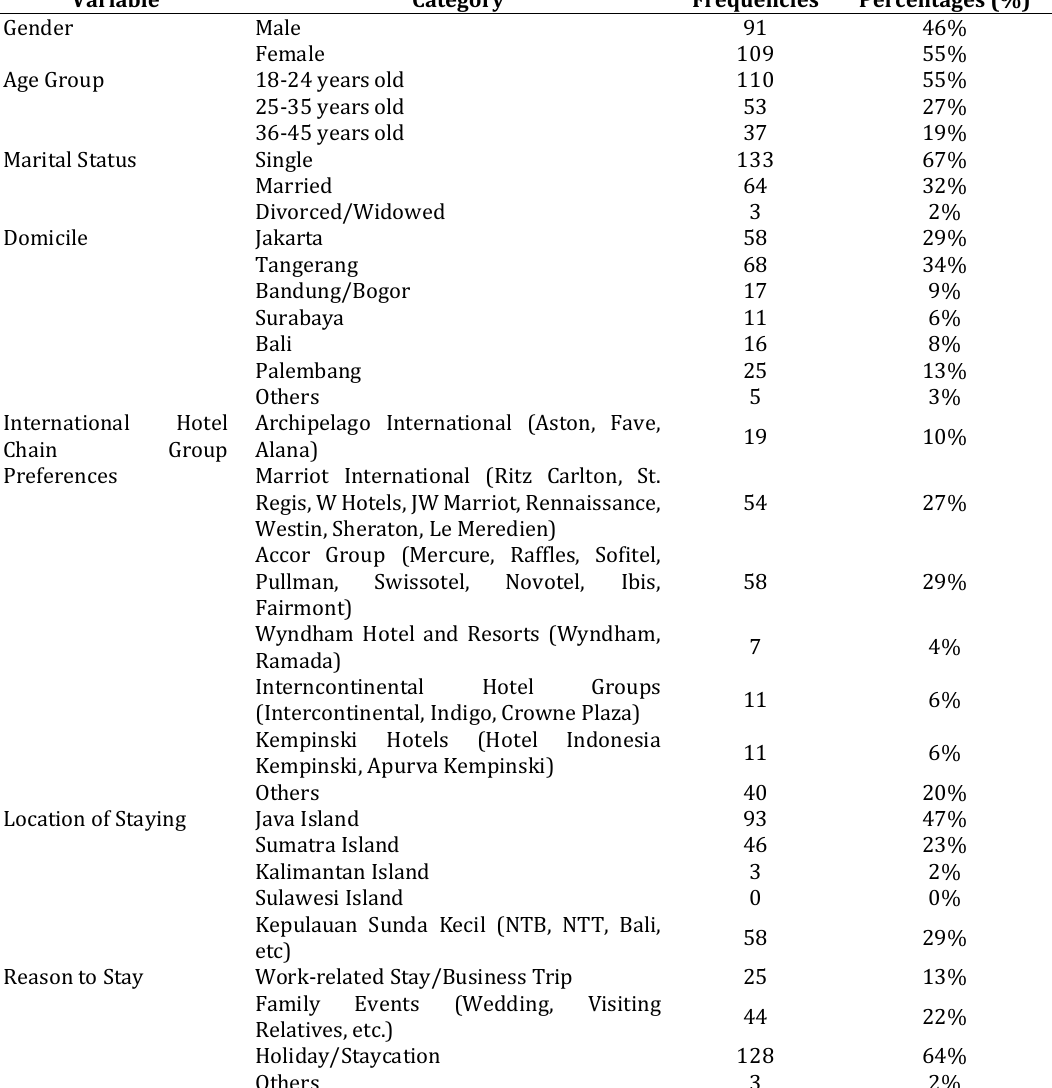
Table 3: Demographics of Subjects in International Chain Hotel